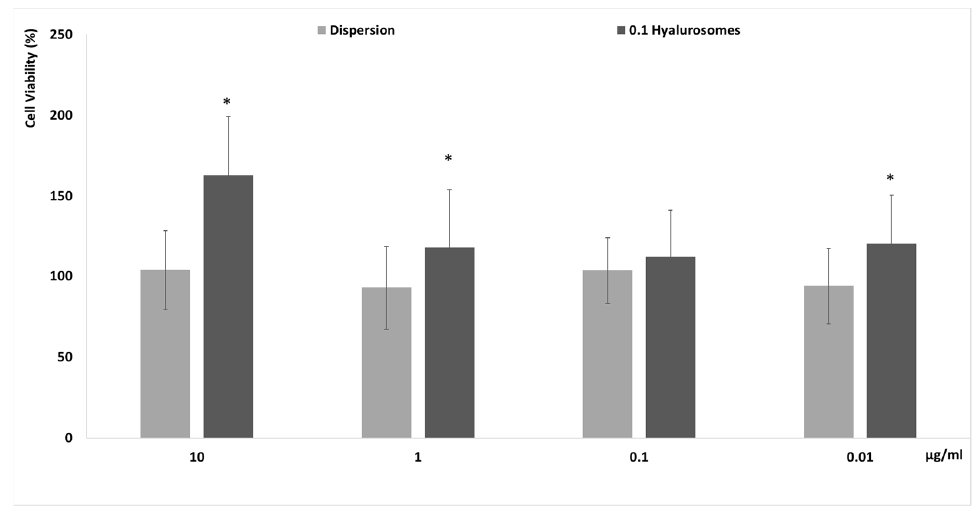
Figure 2 . Cell viability of fibroblasts treated for 48 h with extract in dispersion or loaded in hyalurosomes diluted to reach 10, 1, 0.1, 0.01 µg/mL of extract. Data are reported as mean values ( n = 9) ± standard deviations (error bars) of cell viability expressed as the percentage of untreated cells (100% of viability). Symbol (*) indicates that the viability of cells treated with 0.1 hyalurosomes is statistically different from that of cells treated with the extract in dispersion ( p < 0.05).